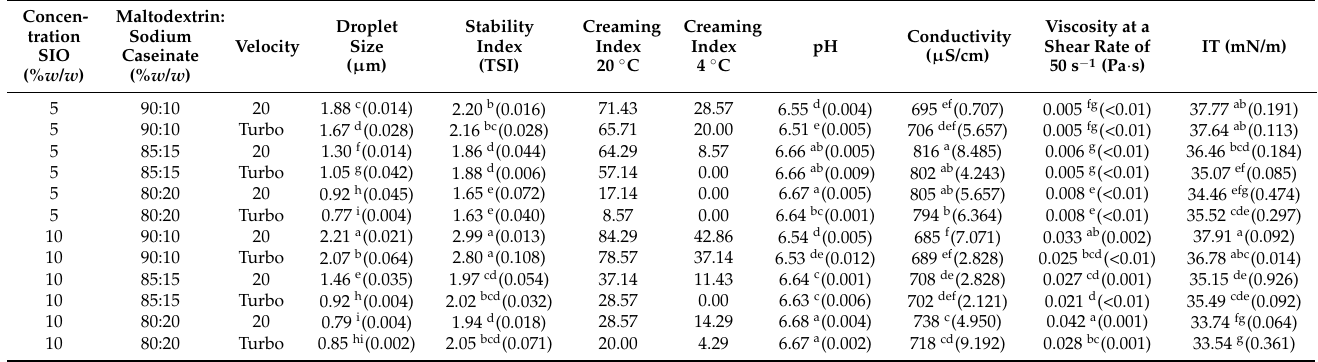
Table 1. Experimental design for preparation of emulsions with conventional homogenization and physicochemical properties evaluated: droplet size, stability index, creaming index (4 and 20 ◦ C), pH, conductivity, viscosity, and interfacial tension (IT).